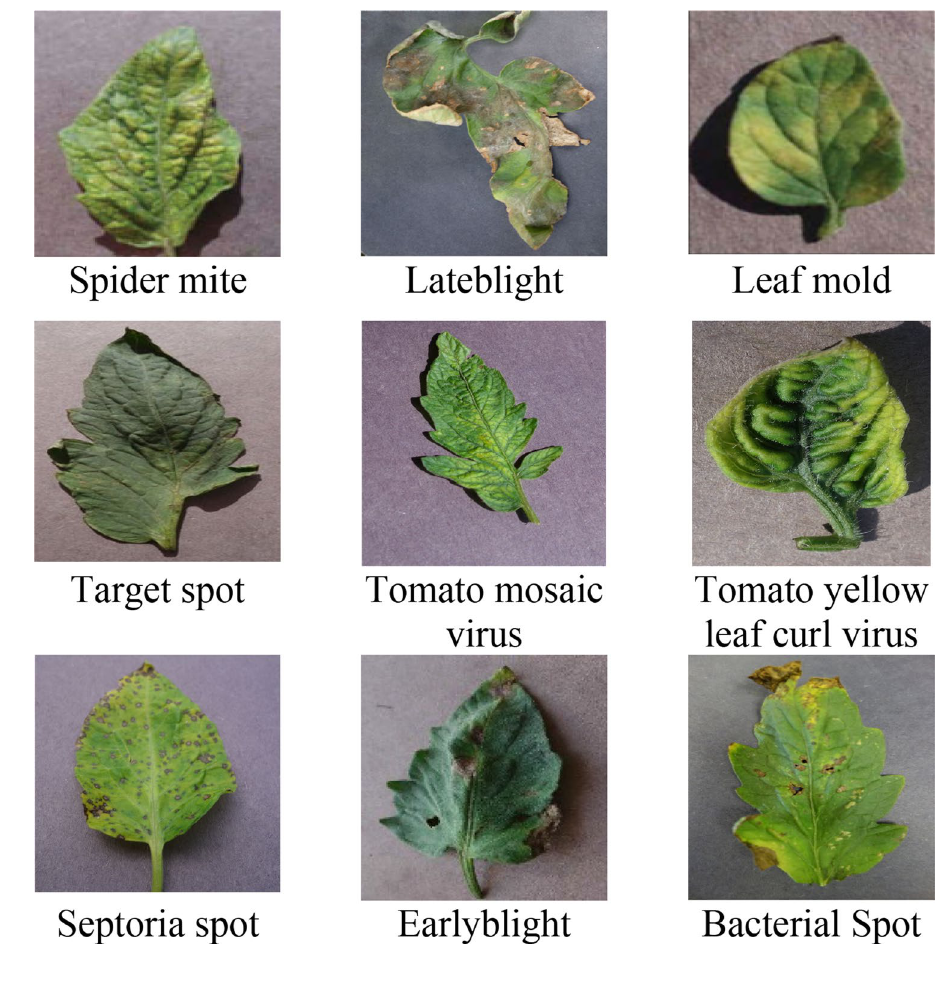
Fig. 5 Extracted images from dataset